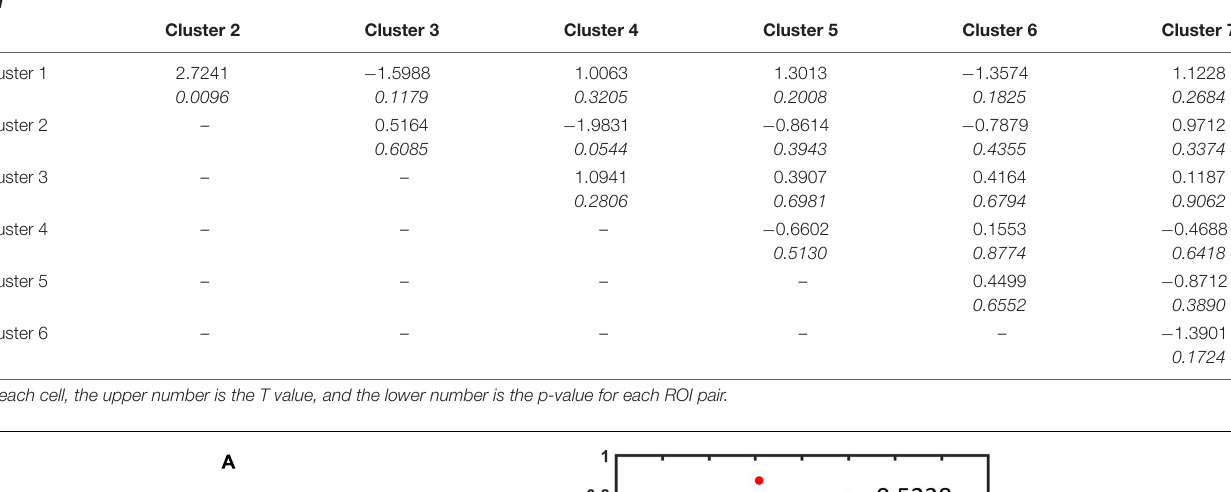
result indicated that the correlation of paired BOLD signals was negatively correlated, while the other 14 subjects in the AD group showed a positive FC between Clusters 1 and 2. However, all